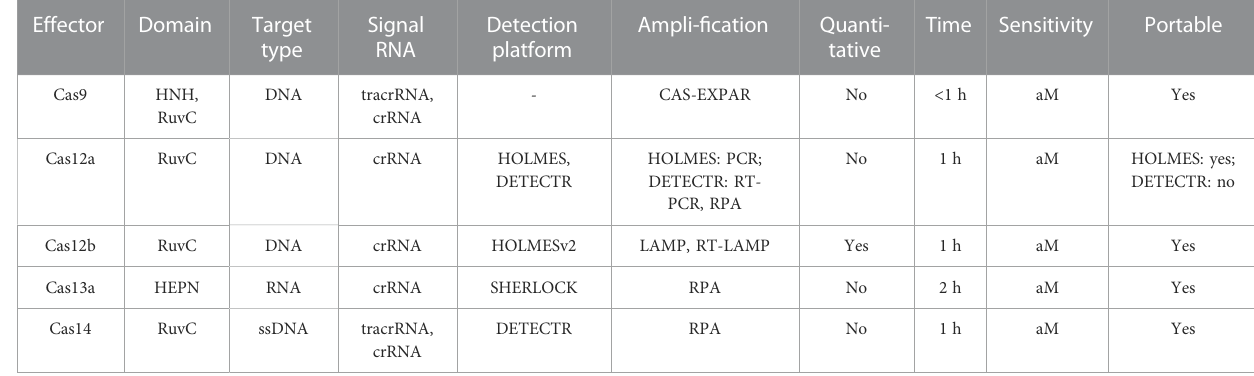
TABLE 1 Comparison of common CRISPR